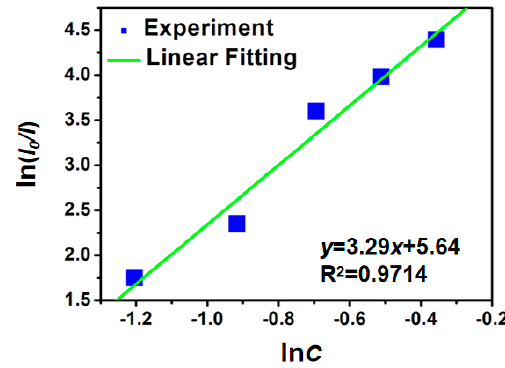
Figure 8. The dependence of ln( I 0 / I ) on ln C in the CTP: x Mn 2+ phosphors.